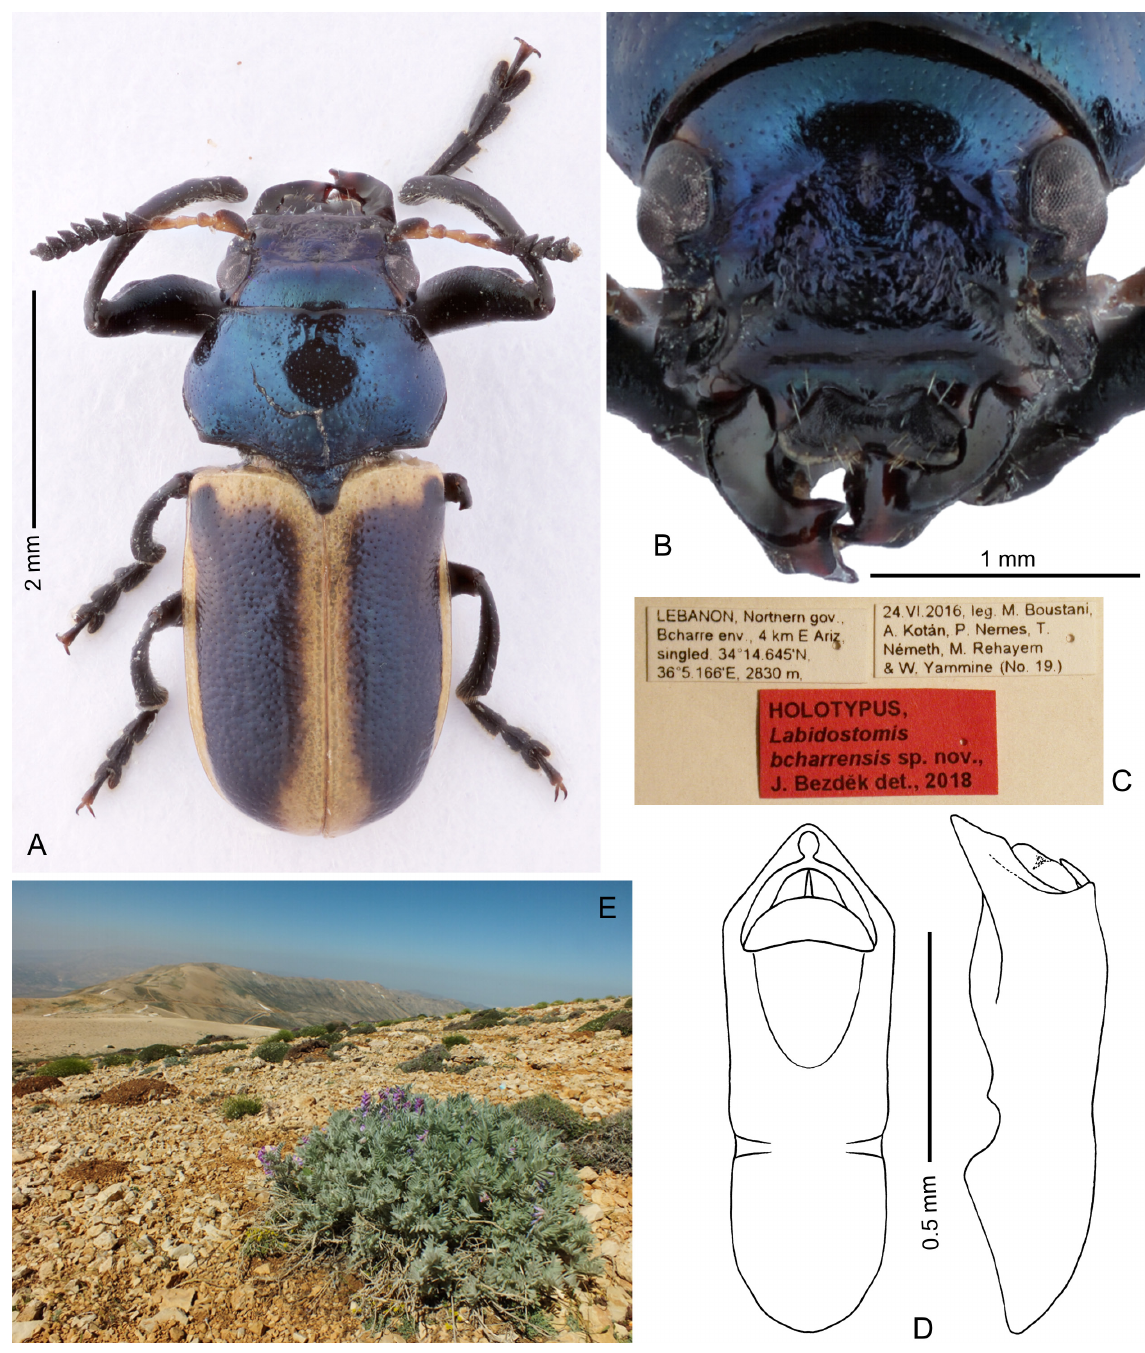
Fig. 1. Labidostomis bcharrensis Bezděk sp. nov., holotype, ♂, 5.6 mm (HNHM). A . Dorsal view. B . Head. C . Labels. D . Aedeagus in dorsal and lateral views. E . Habitat (photo by Tamász